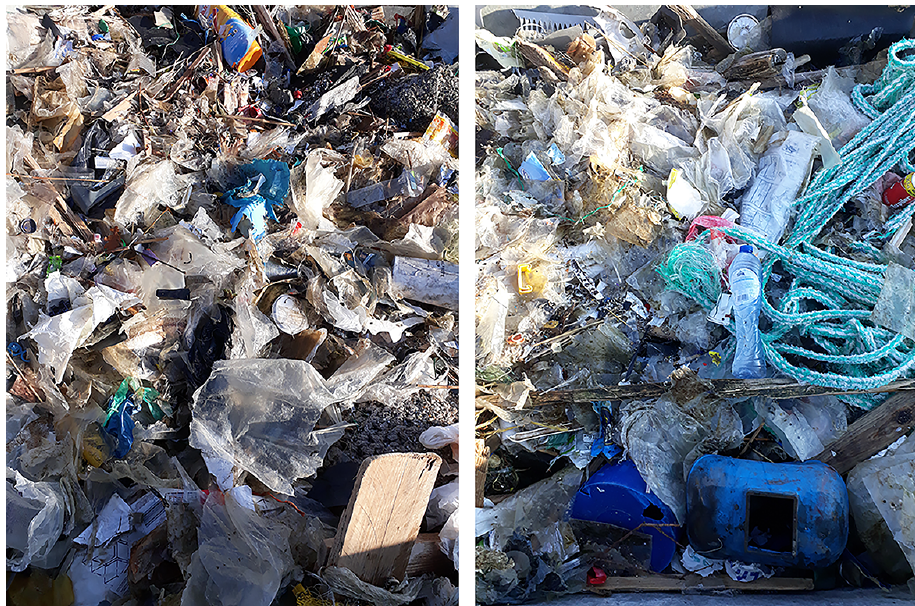
Figure 2. Litter specimens found in the Port of Antwerp, Belgium.